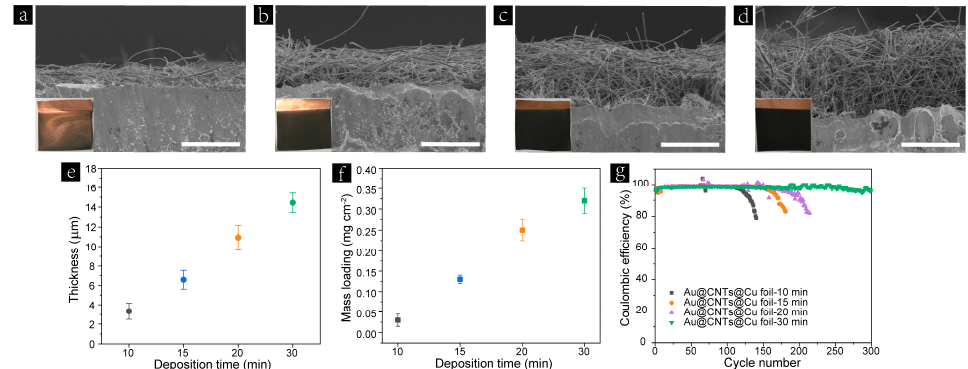
Figure 2. Cross-sectional SEM images of as-prepared Au@CNTs@Cu foil with different electrophoretic deposition times: ( a ) 10, ( b ) 15, ( c ) 20, and ( d ) 30 min. All scale bars are 10 μ m. Insets show their corresponding digital photographs. ( e ) The thickness and ( f ) mass loading of as-prepared